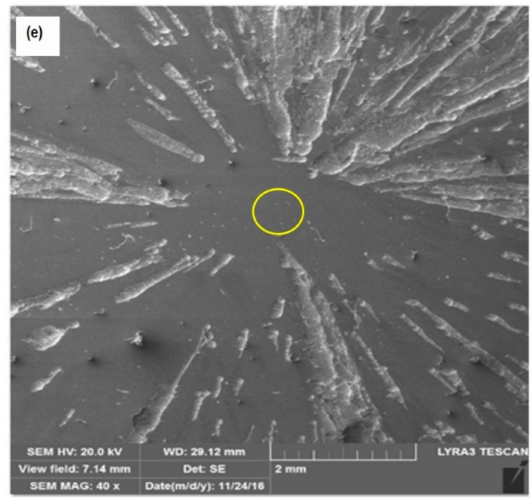
Figure 4. Field Emission Scanning Electron Microscopy (FE-SEM) micrographs ( a – e ) of wear scars after corrosion experiments (without solid particles) at 15–90 ◦ angles (circled points show high-velocity regions).